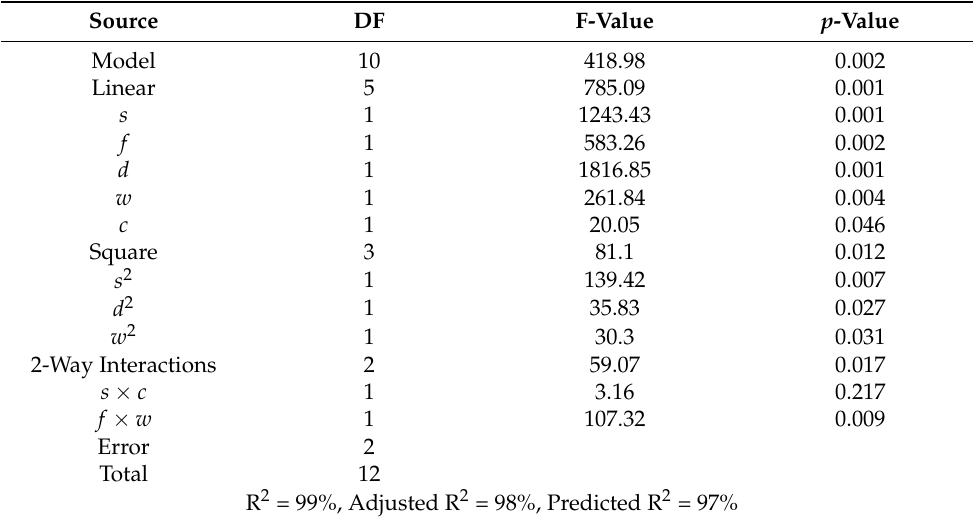
Table 7. Regression analysis of variance for material removal